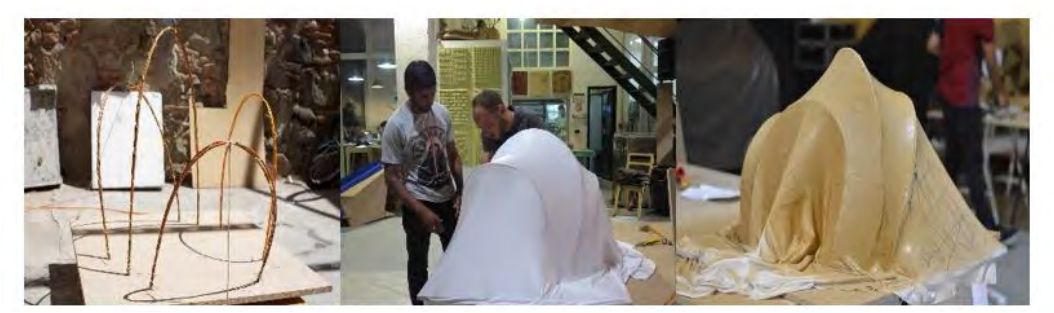
Figure 9. (a) Placement of the 3peripheral and one middle arch materialized by a cluster of 2 or 3 0.3 mm diameter reeds. (b) Placement of lycra fabric stretched over the different arches. (c) First liquid clay mix robotically applied on the fabric and reeds formwork.